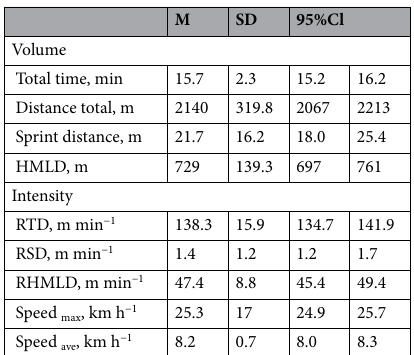
Table 2. Means (M), standard deviations (SD) and 95% confidence intervals (95% CI) for indicators of volume and intensity (per unit playing time) of effort during U16 Hockey5s